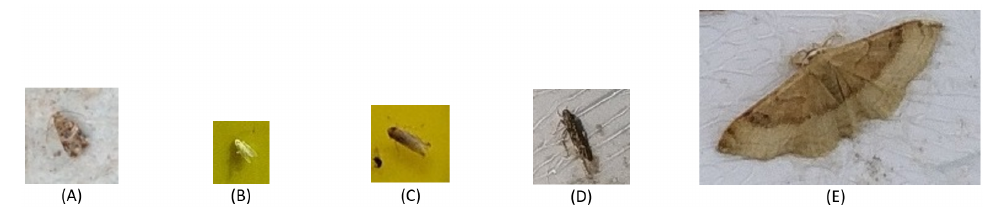
Figure 1. Illustrative examples of detected insects for viticulture pest monitoring (in scale): ( A ) Grapevine Moth; ( B ) Green Leafhopper; ( C ) “Flavescence Dorée” Leafhopper; ( D ) Tomato Moth; and ( E ) Morphotype